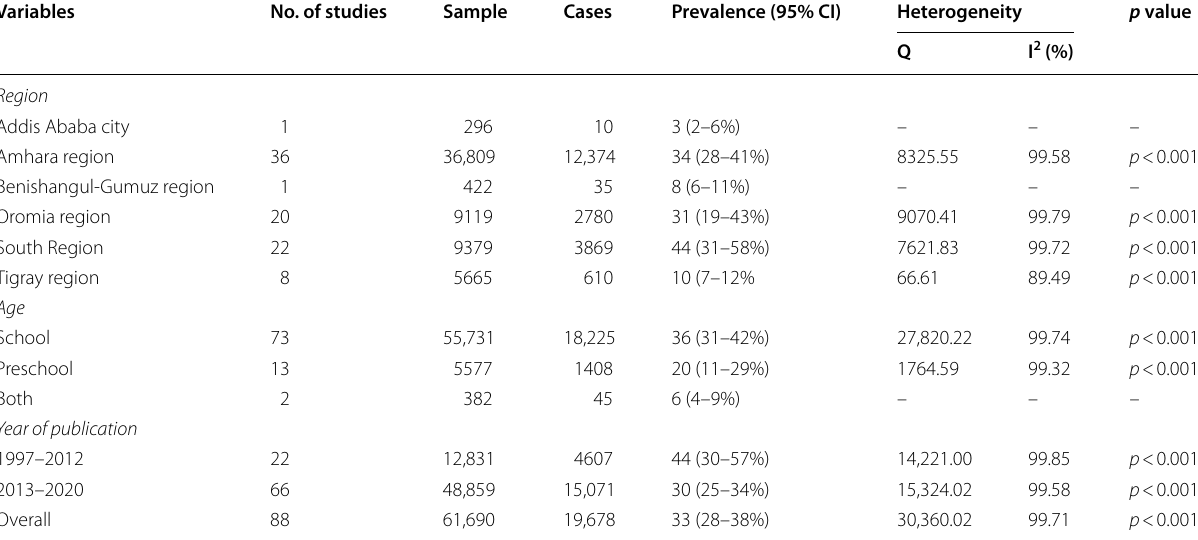
Table 3 Prevalence of soil-transmitted helminths (STHs) by region, age of children and year of publication among Ethiopian Children,